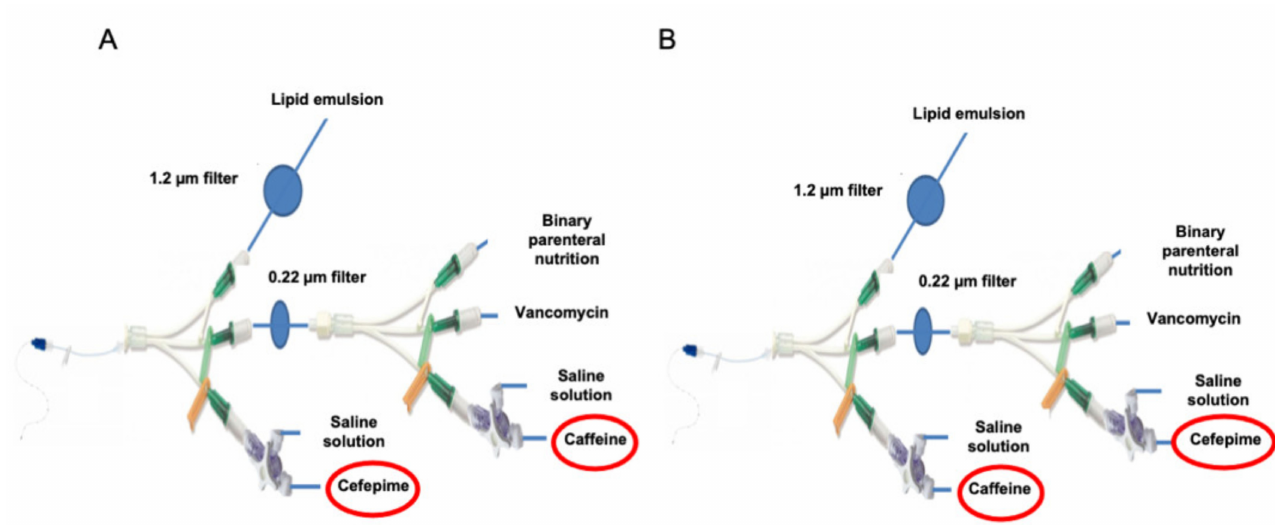
Figure 1. Infusion line used in the neonatal intensive care unit. CEF infusion line with cefepime placed on the unfiltered emergency track ( A ); CAF infusion line with caffeine placed on the unfiltered emergency route ( B ).